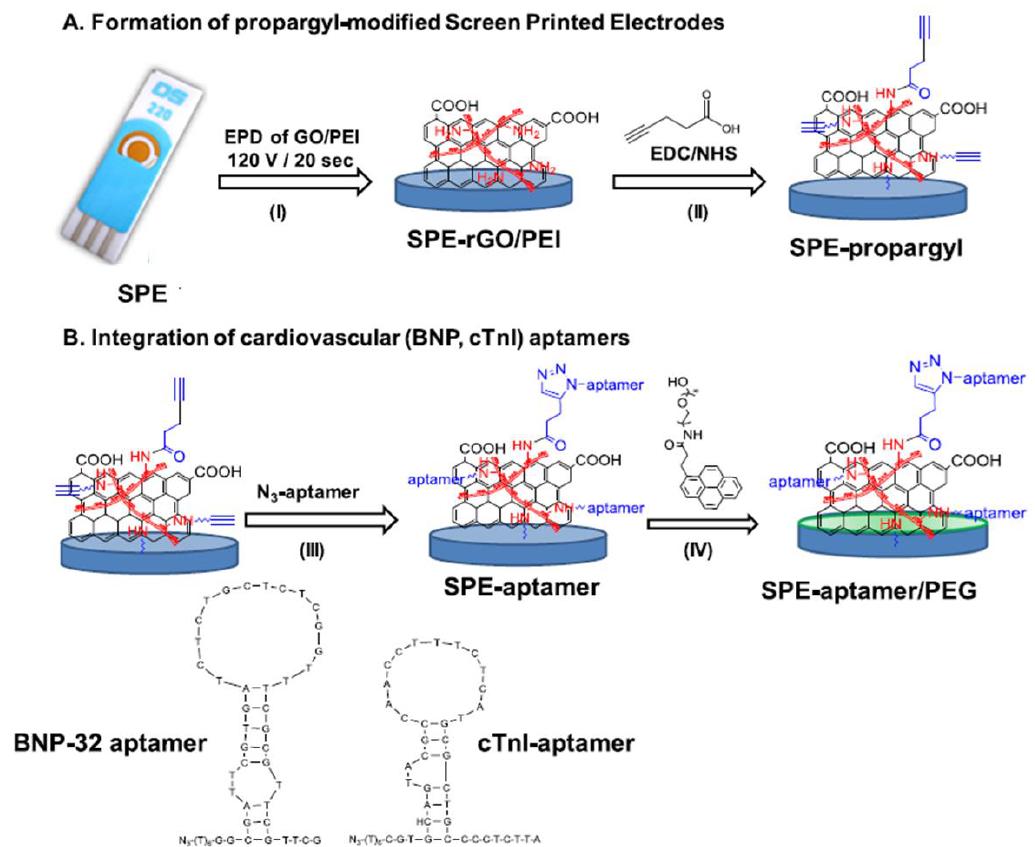
Figure 9. Steps involved in the construction of an electrochemical aptasensor for BNP and cTnI cardiac biomarkers. Preparation of gold SPE-rGO / polyethyleneimine (PEI) by electrophoretic deposition (EPD) of rGO / PEI onto gold screen-printed electrodes (I) and covalent binding of propargylacetic acid and PEI (II) ( A ). Integration of N 3 -functionalized aptamers by click chemistry (III), and blocking with pyrene-polyethylene glycol (PEG) (green layer) ( B ). Reproduced from [78] with permission.